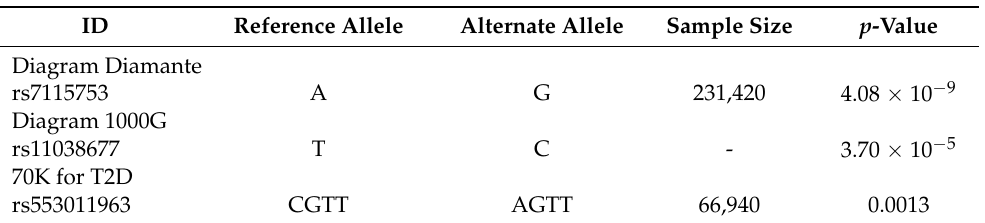
Table 2. Top MAPK8IP1 variants at ± 100 Kb and their associations with T2D. Data obtained from the TIGER data portal.